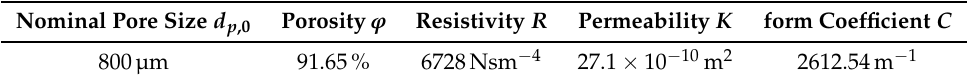
Table 1. Characterizing properties of the porous metal foam P800 for a sample thickness of 6cm as characterized by Rubio Carpio et al.